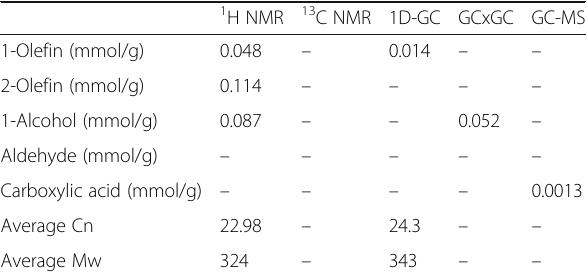
Table 10 Class group quantification across the NMR and GC techniques, Wax1